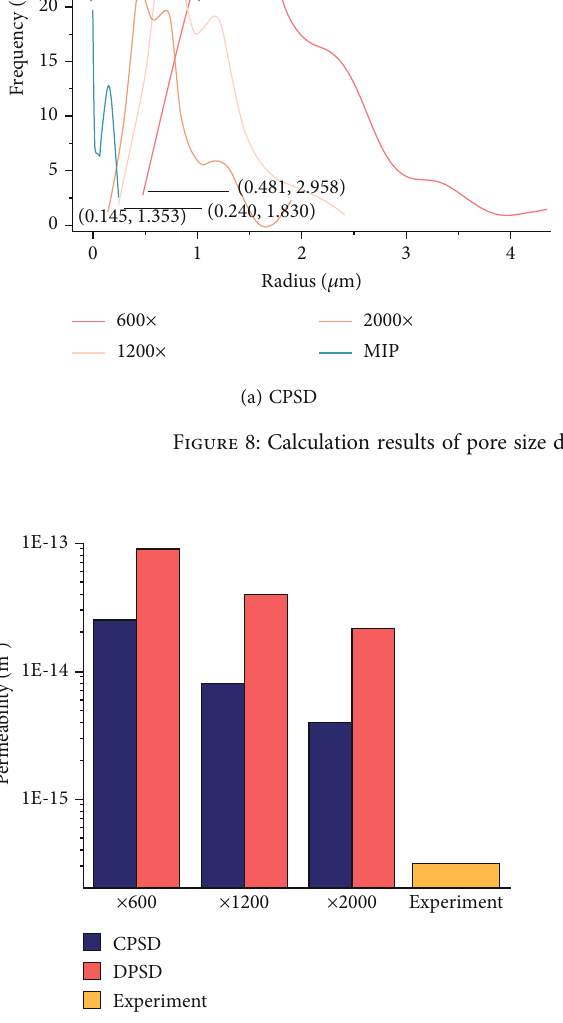
Figure 9: Permeability calculation results based on digital images and laboratory